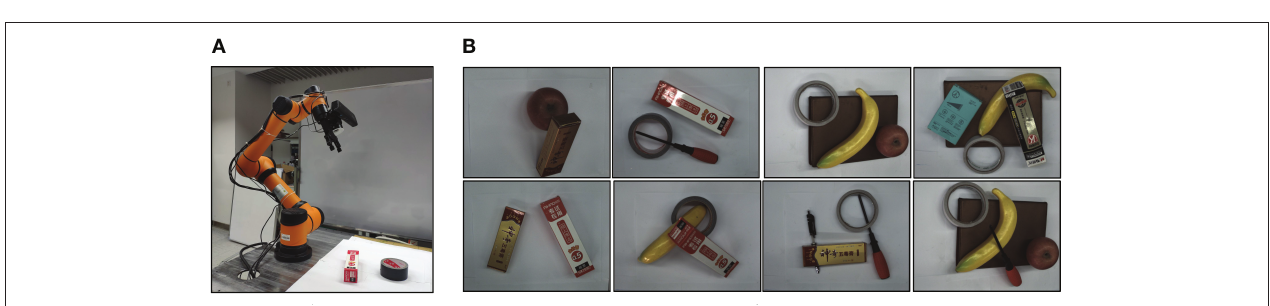
FIGURE 6 | Feature visualization for graph-based visual manipulation relationship reasoning.